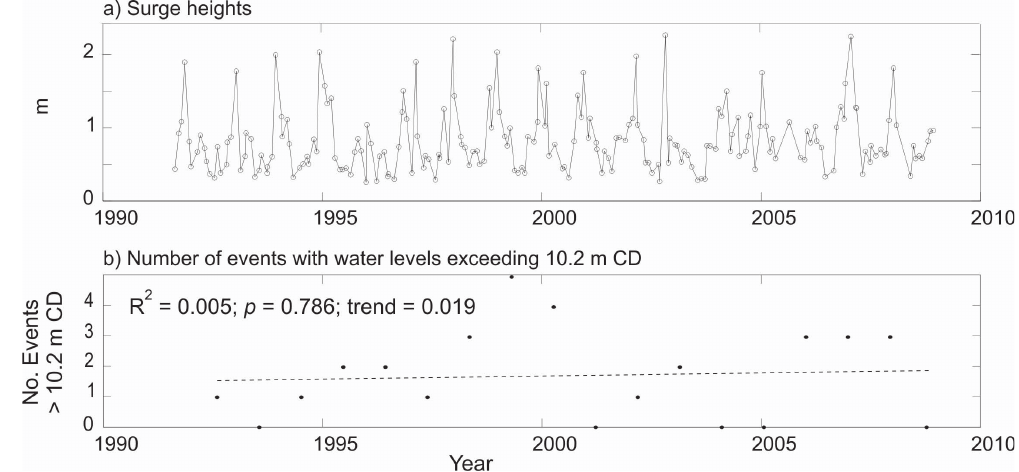
Fig. 3. (a) Maximum monthly positive surge levels and (b) number of events per year of extreme water levels ( > 10.2m CD) at Liverpool Gladstone Dock from 1991 to 2009. The dashed line indicates the linear trend.